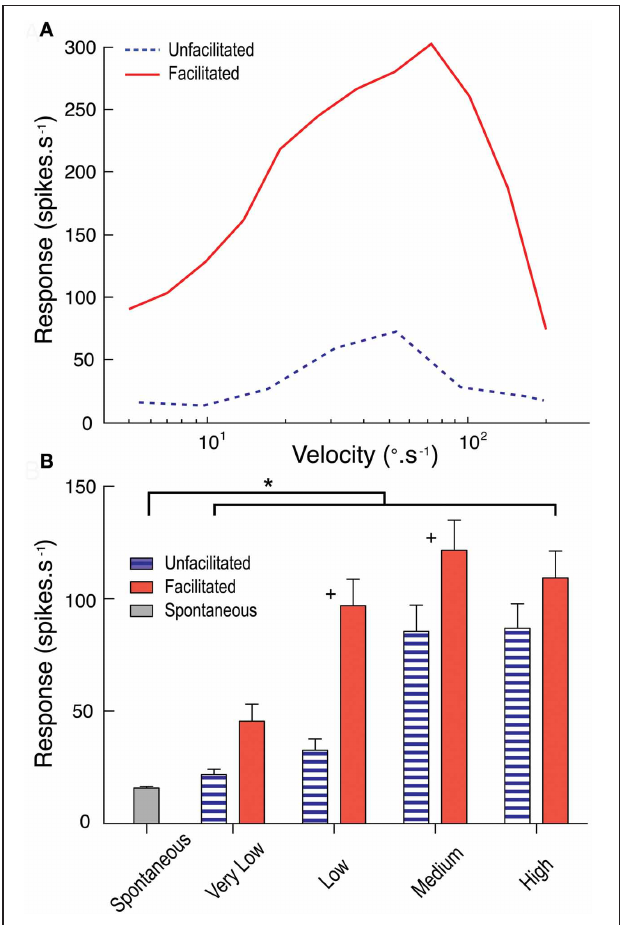
FIGURE 6 | (A) The unfacilitated velocity tuning curve (blue dotted line) measures CSTMD1’s response to targets commencing movement within the receptive field. The facilitated velocity tuning curve (red line) is measured at the equivalent receptive field location, however follows a facilitating stimulus (target moving at 33 ◦ .s − 1 ). Facilitated responses are much stronger across the velocity range. (B) Results pooled by grouping velocity ranges (very low, < 10 ◦ .s − 1 ; low, between 10 and 30 ◦ .s − 1 ; medium, between 30 and 100 ◦ .s − 1 ; and high, > 100 ◦ .s − 1 ; 10 trials per velocity in 3 neurons) show facilitation has the largest effect at low and medium range velocities ( + = significant difference between facilitated and unfacilitated, p < 0 . 05; ∗ = significant difference from spontaneous activity, p < 0 .